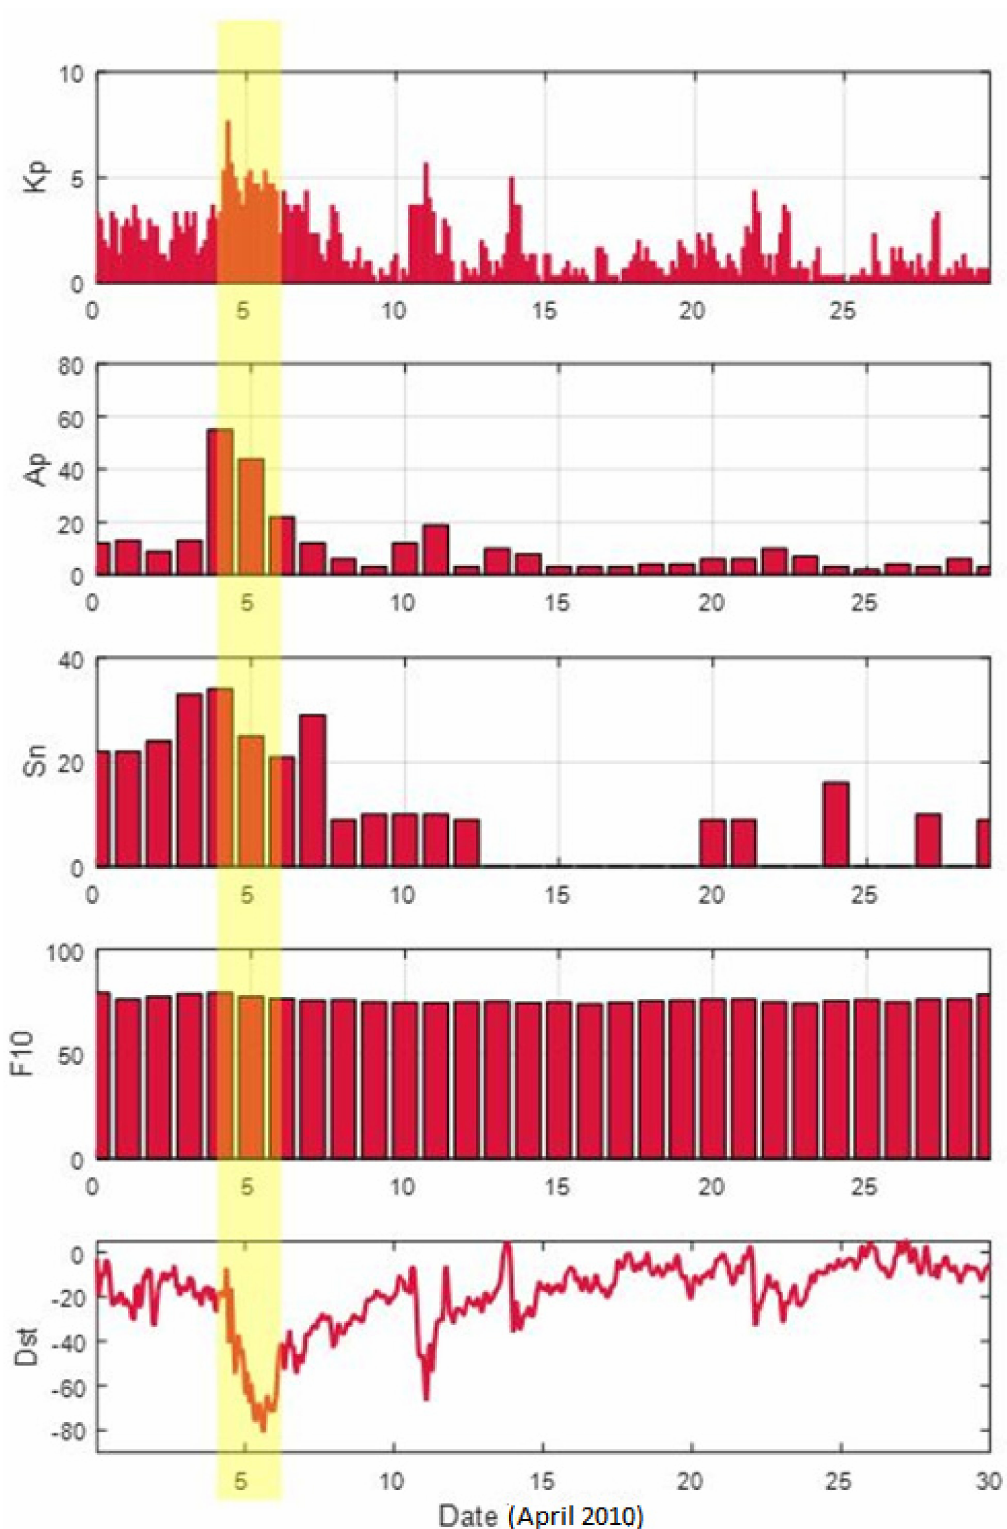
Figure 3. Planetary indices during the month of April 2010. Anomalies are indicated by highlighted